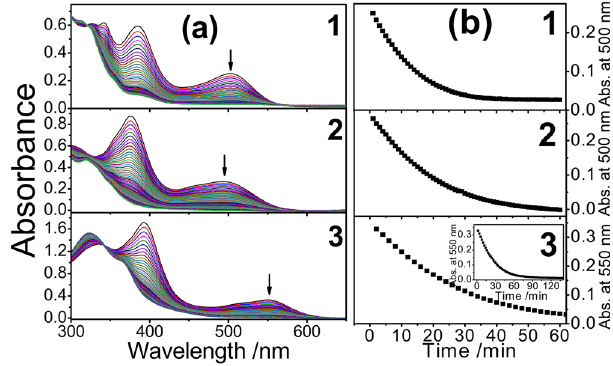
Fig. 8 Photostability studies of 1 – 3. a UV-vis spectral changes of 1 – 3 in CH 3 CN solution at 298 K upon irradiation at 500 nm. b The plot of absorbance versus time for 1 and 2 (1-min time interval), and 3 (2-min time interval). the diiridium(II) framework, resulting from the population of π * (Ir(II) – Ir(II)) orbital. In 1 , an additional anodic peak at – 0.16 V is only emerged after the fi rst reduction scan beyond – 0.40 V (Supplementary Fig. S43a), indicative of the oxidation of the decomposed product. Similar to the photophysical properties, the observation of almost the same reduction potentials for the reduction and oxidation of 1' (Supplementary Fig. S44) and 1 , indicated the insigni fi cant effect from the change of counter anion in solution state.